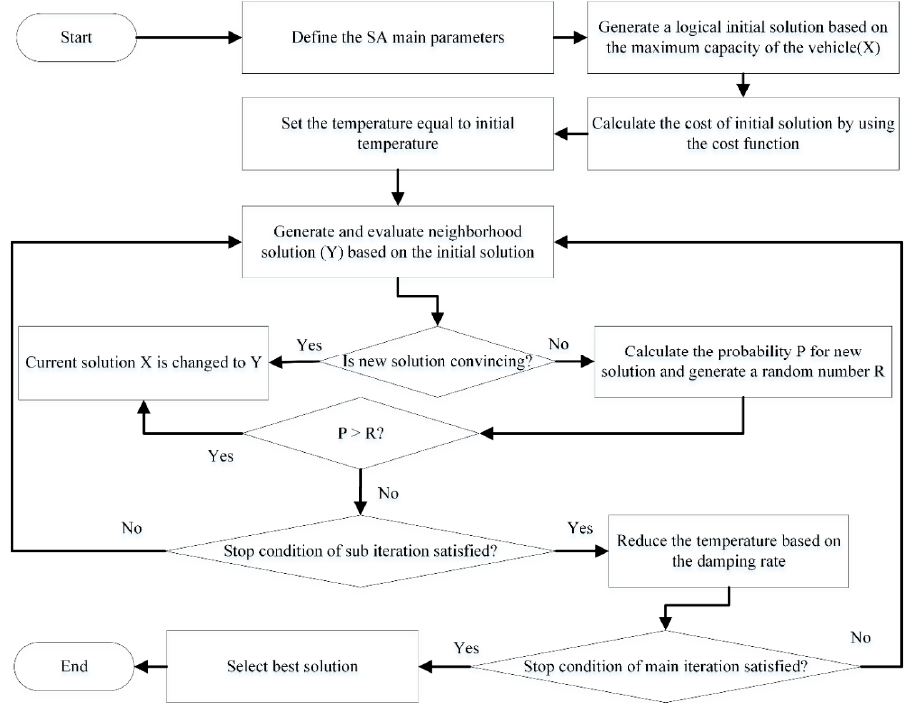
Figure 3. The overview of the simulated annealing (SA)